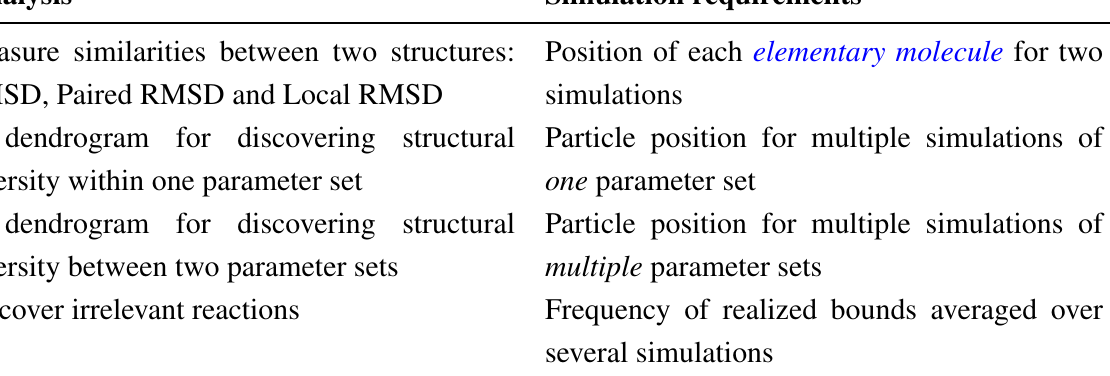
Table 4. Analysis methods and required simulation